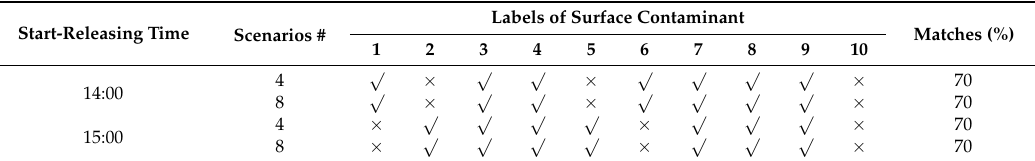
Table 4. Examples of water surface contaminant comparison. The simulated results were compared with observation data.